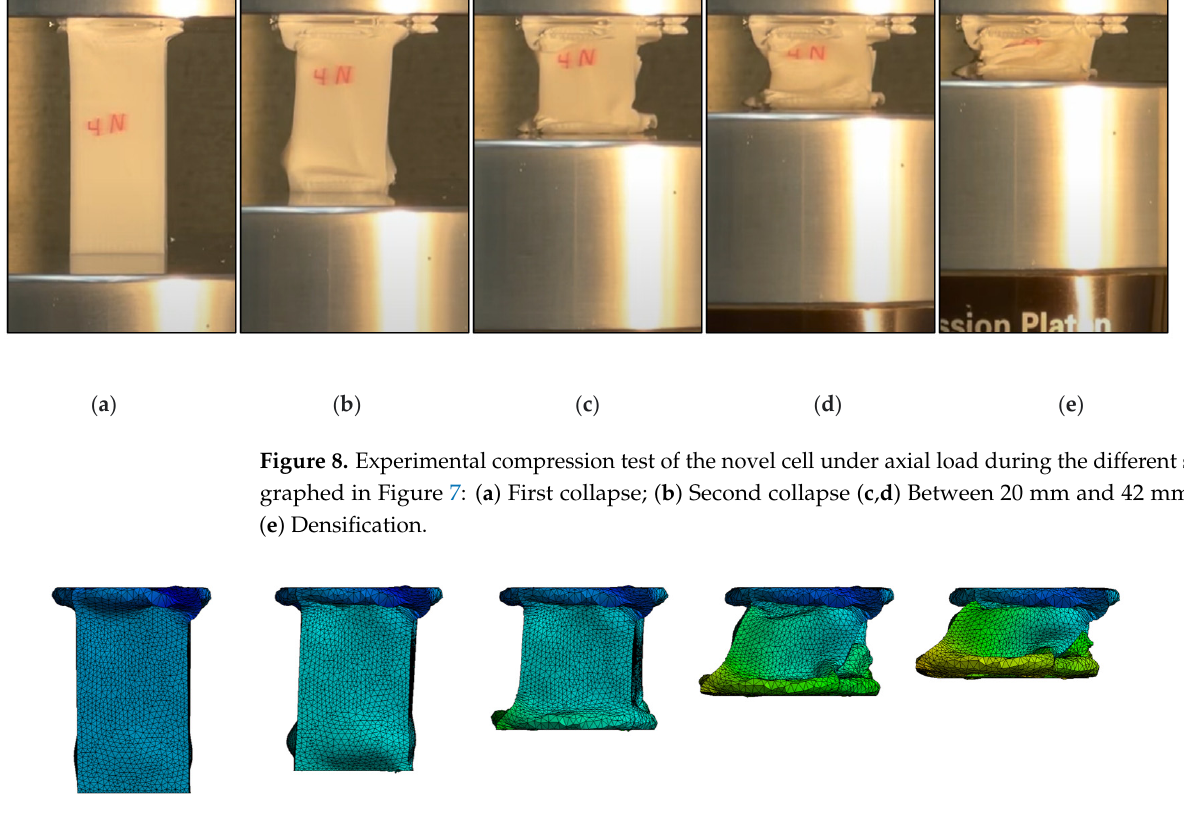
Figure 9. FE analysis of deformation process for the novel cell under axial load.